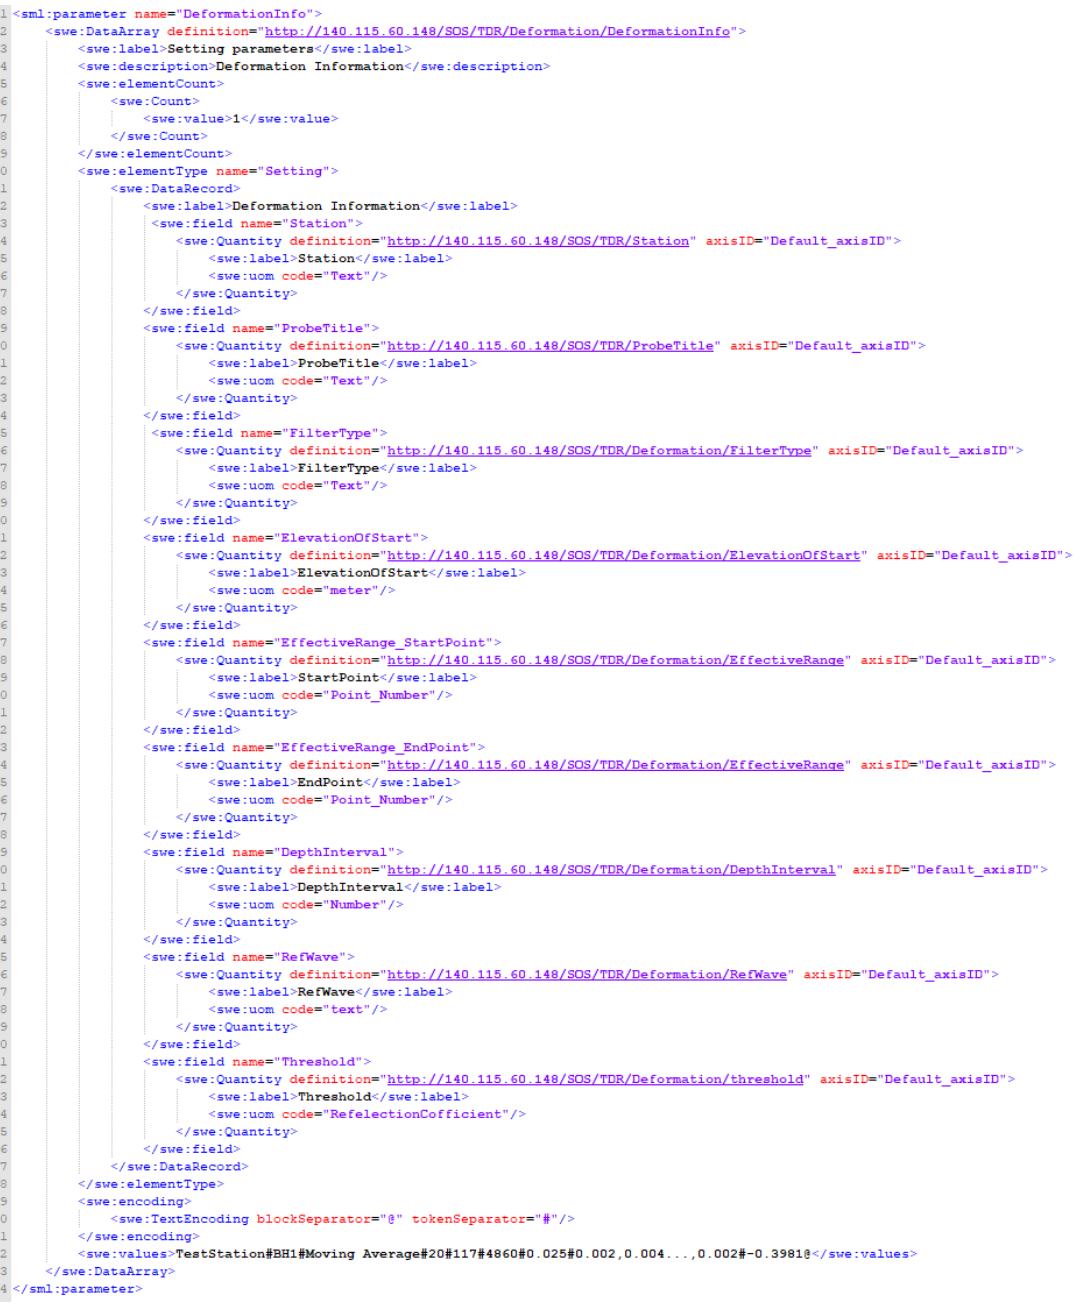
Figure 12. Insert sensor XML request of InsertSensor_DeformationInfo